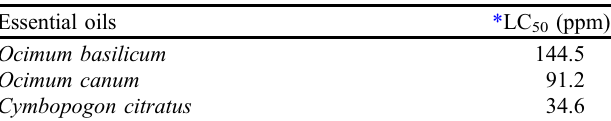
Table 3. Larvicidal activity of essential oils on the fourth-stage larvae of Anopheles funestus